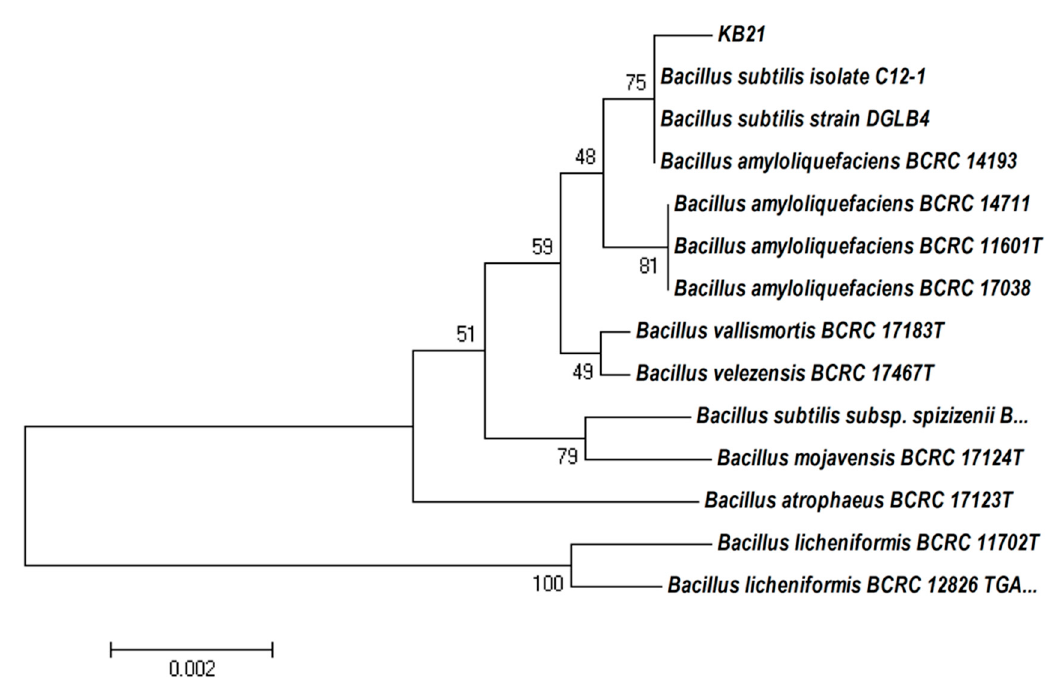
Figure 1. Characterization and identification of strain KB21. Neighbor-joining tree showing phylogenetic positions of strain KB21 and representatives of related taxa, based on 16S rRNA gene sequences. Bootstrap values (expressed as percentages of 1000 replications) are shown at branch points.